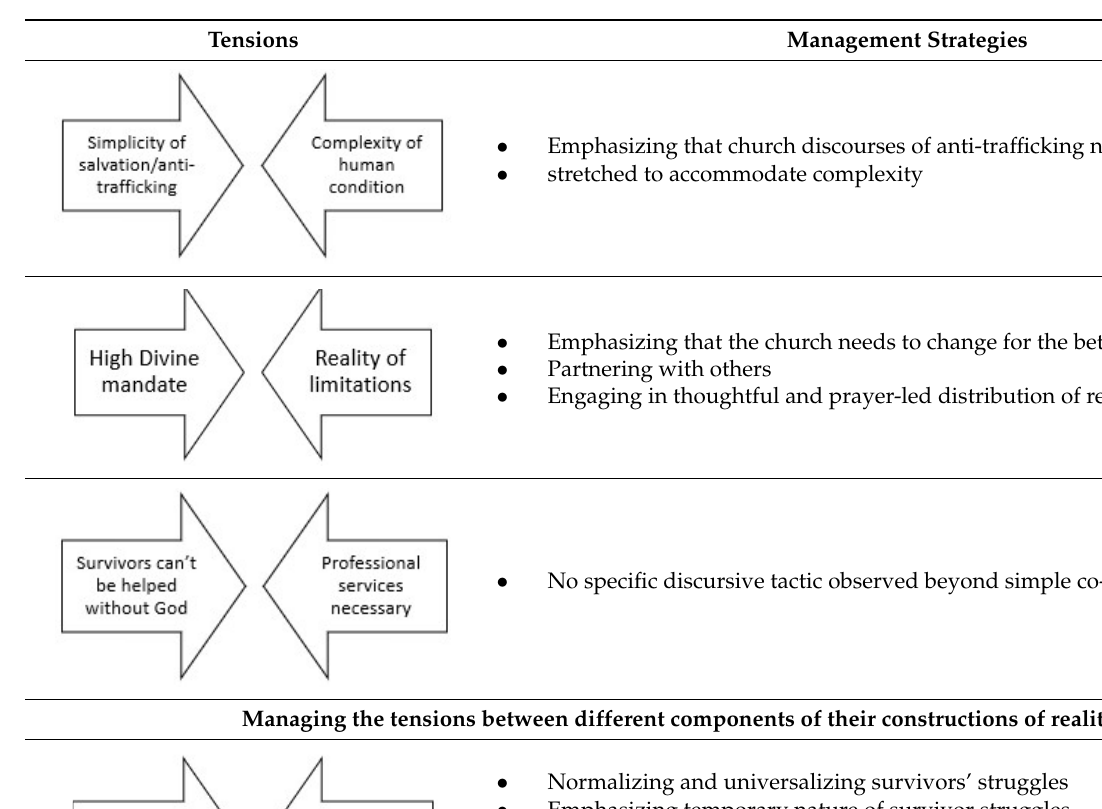
Table 3. Managing the Tensions between Ideal and Reality.